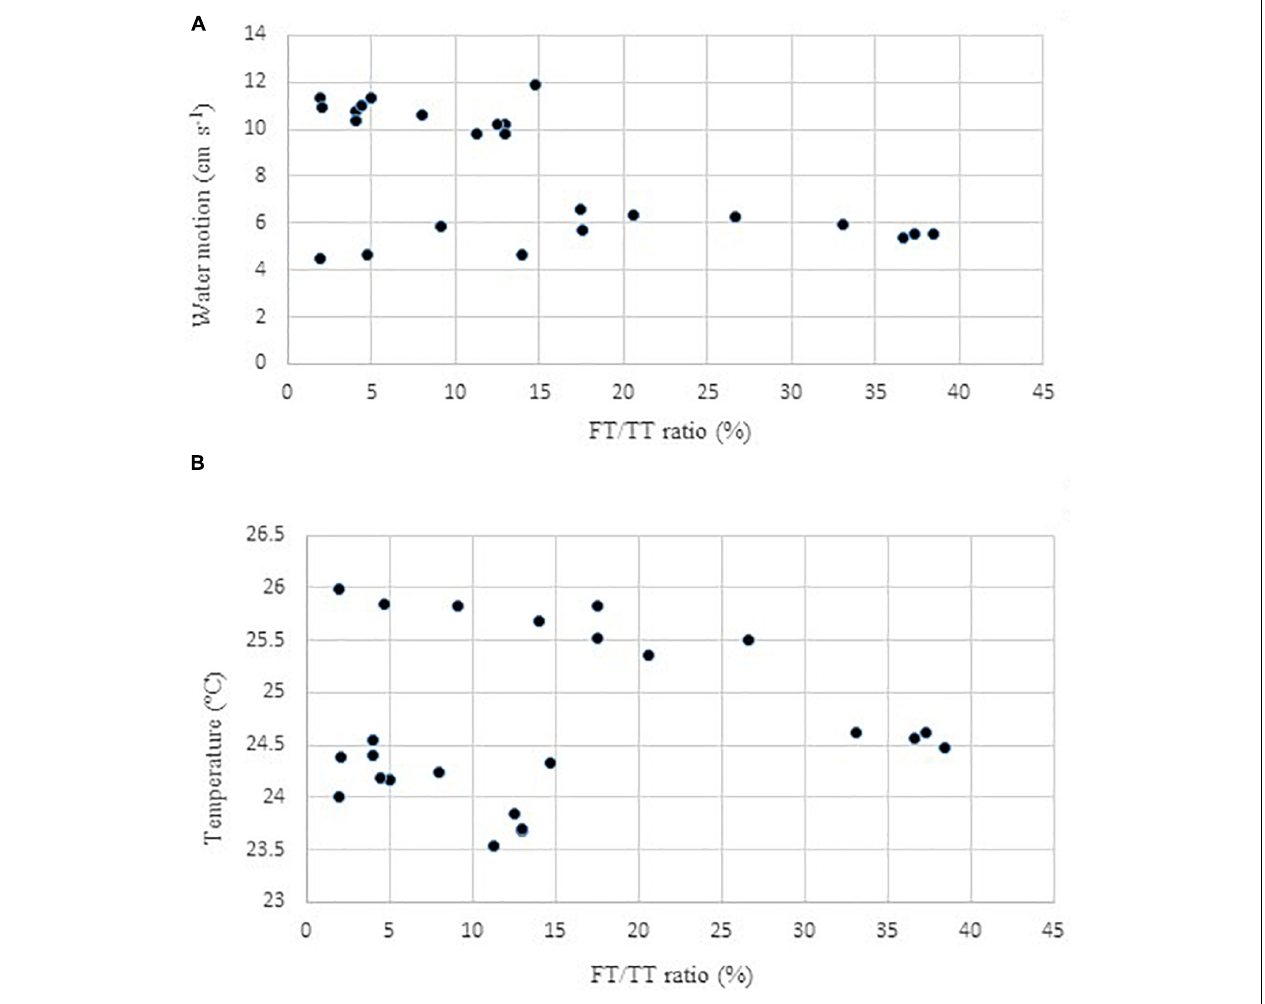
FIGURE 6 | Relationship among FT/TT ratio, (A) water motion, and (B) sea water temperature (B) on the pooled data ( n = 120). R values are provided in the